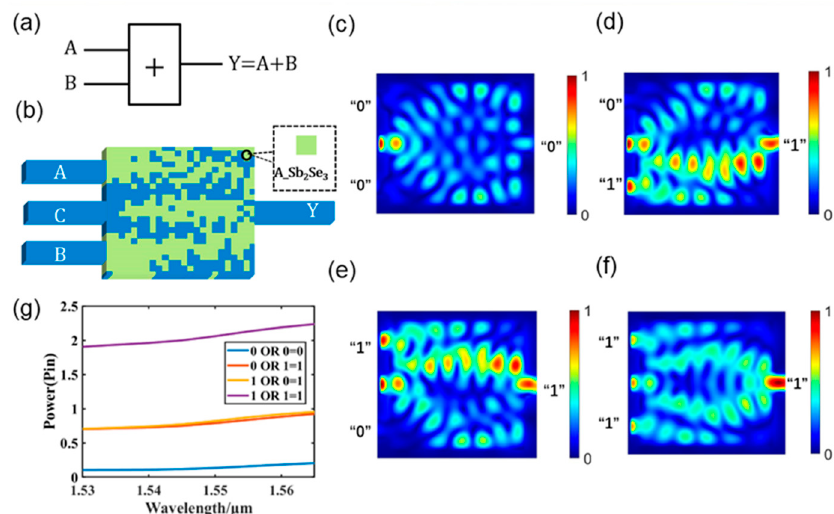
Figure 3. Photonic OR logic gate. ( a ) Graphical symbols of OR logic gate; ( b ) designed OR logic gate; ( c – f ) light field intensity distributions of all operations of the OR logic gate; ( g ) output optical power diagram of the OR logic gate in the C-band. Table 1. Photonic OR logic gate power and binary output truth table data. OR Gate: Y = A + B.